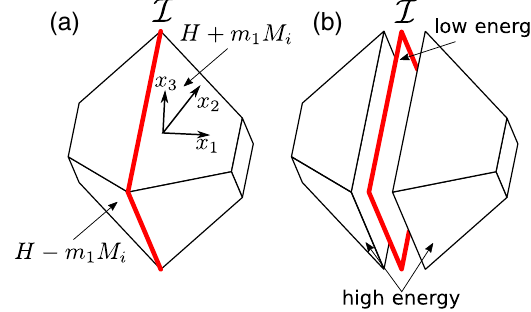
FIG. 10. A three-dimensional, inversion-symmetric, second- order phase can be mapped onto a two-dimensional first-order phase. The map is achieved by adding a crystalline-symmetry- breaking mass term M with opposite prefactors on both sides of a i plane that symmetrically divides the crystal into two halves and that contains the anomalous boundary states (a). Such an addi- tional mass term respects the inversion rotation symmetry and manifestly trivializes the three-dimensional bulk away from the boundary states. The low-energy theory consists of a first-order two-dimensional Hamiltonian